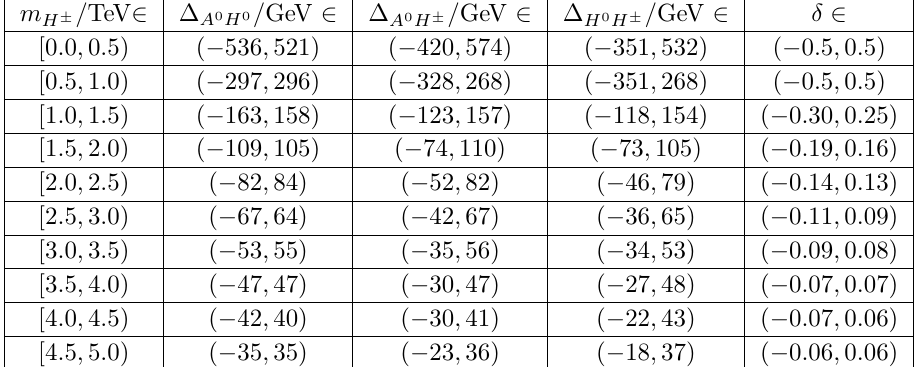
(tan β ) < 2 . 5 . We have defined ∆ ij := m i − m j 10